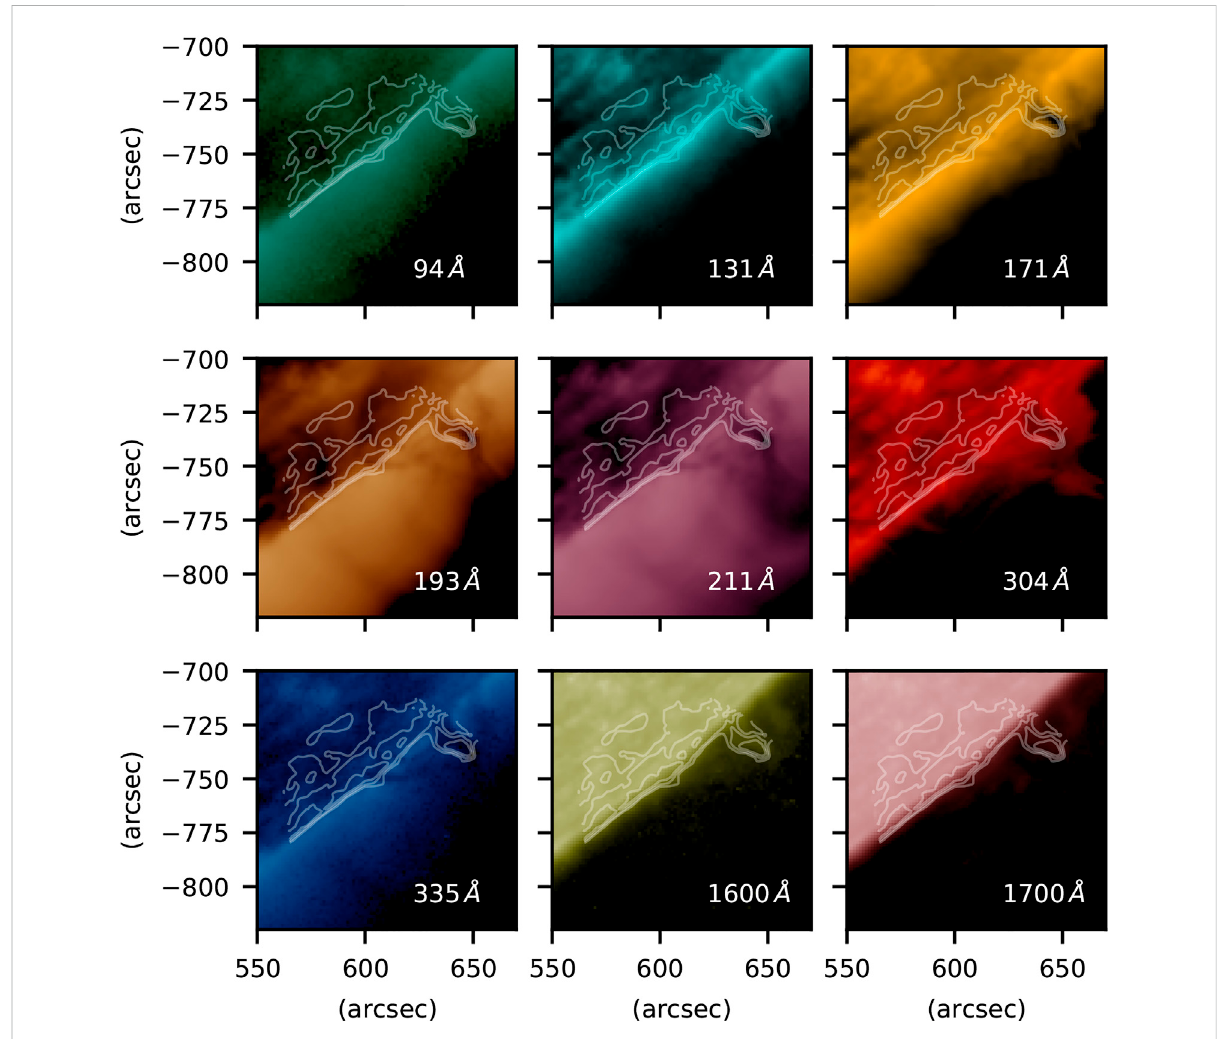
FIGURE 10 Co-aligned images of the ALMA prominence (shown as white contours at relative brightness temperatures of 1000, 2000, and 3000 K) observed with AIA. Reproduced from Labrosse et al.